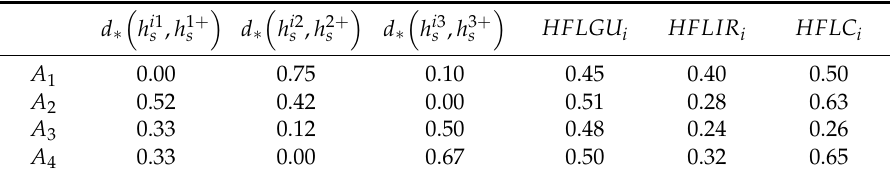
(cid:16) (cid:17) + h ij s , h j In Table 3, d ∗ is the Euclidean distance between each evaluated value h ij s and the s + HFL-PIS h j s . From Table 3, the ranking results of HFLC i